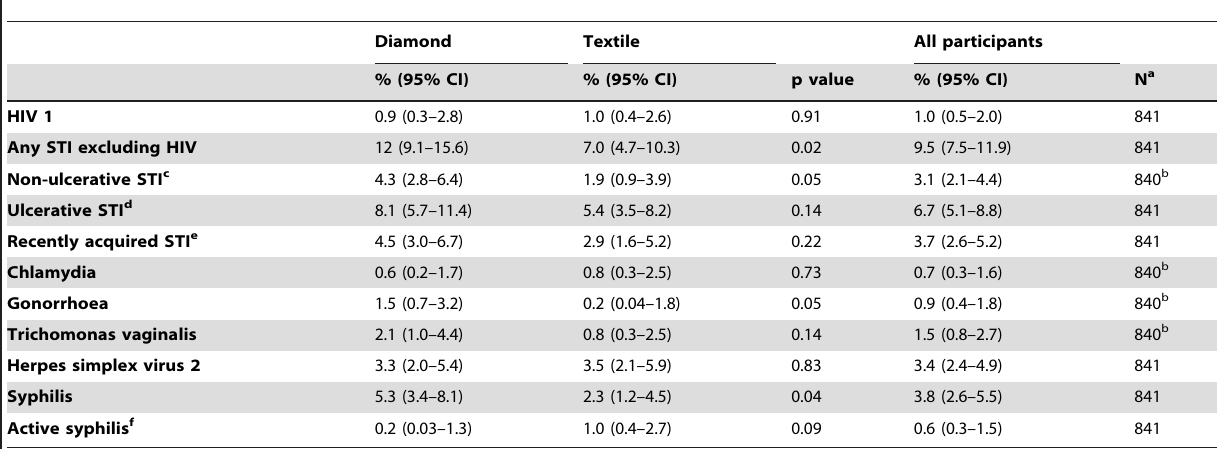
Table 2. Prevalence of HIV-1 infection and STIs among participants by industry.